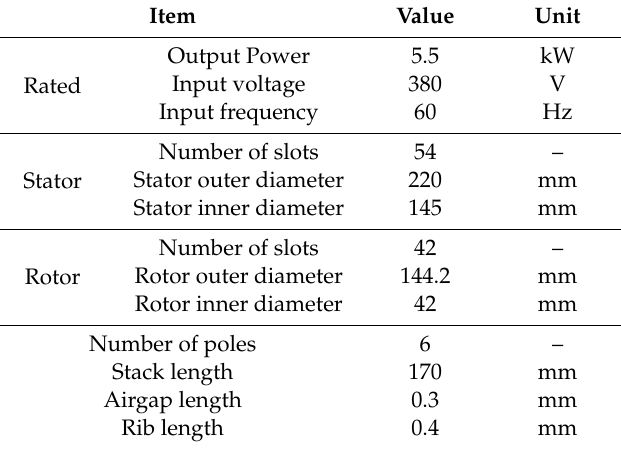
Table 1. Specification of reference